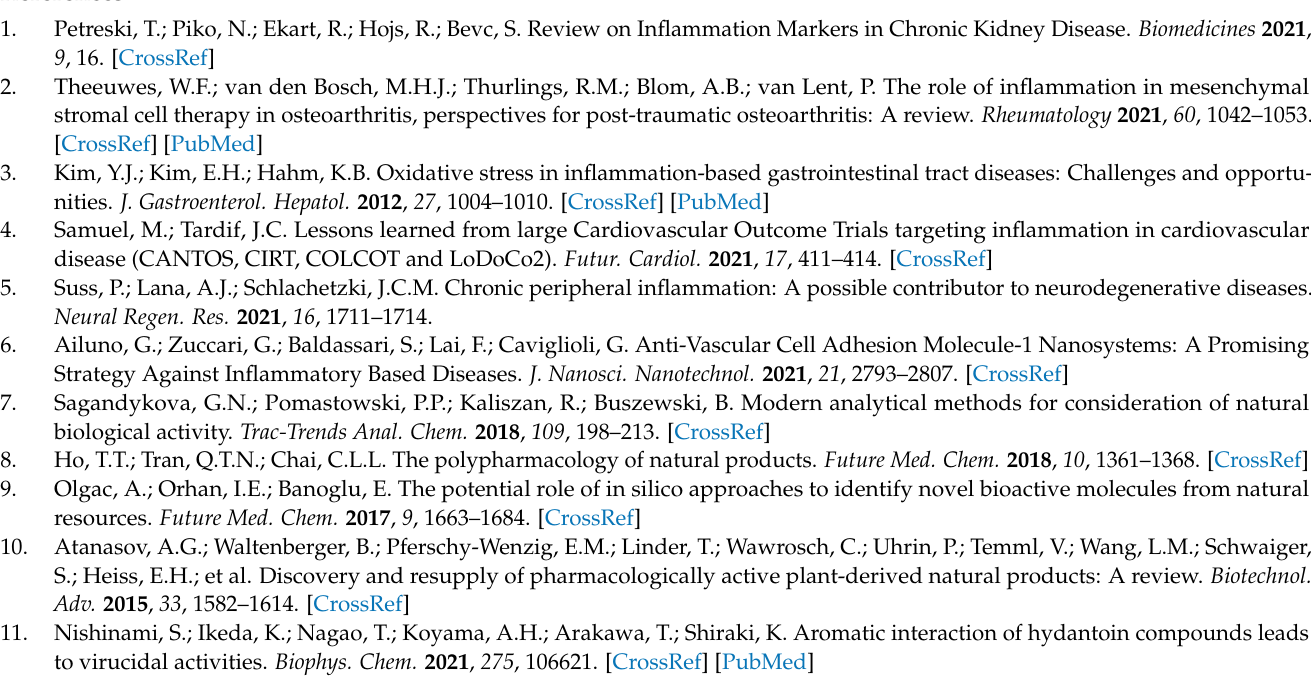
Figure S4 1 H- and 13 C- NMR of compound 4, Figure S5 1 H- and 13 C- NMR of compound